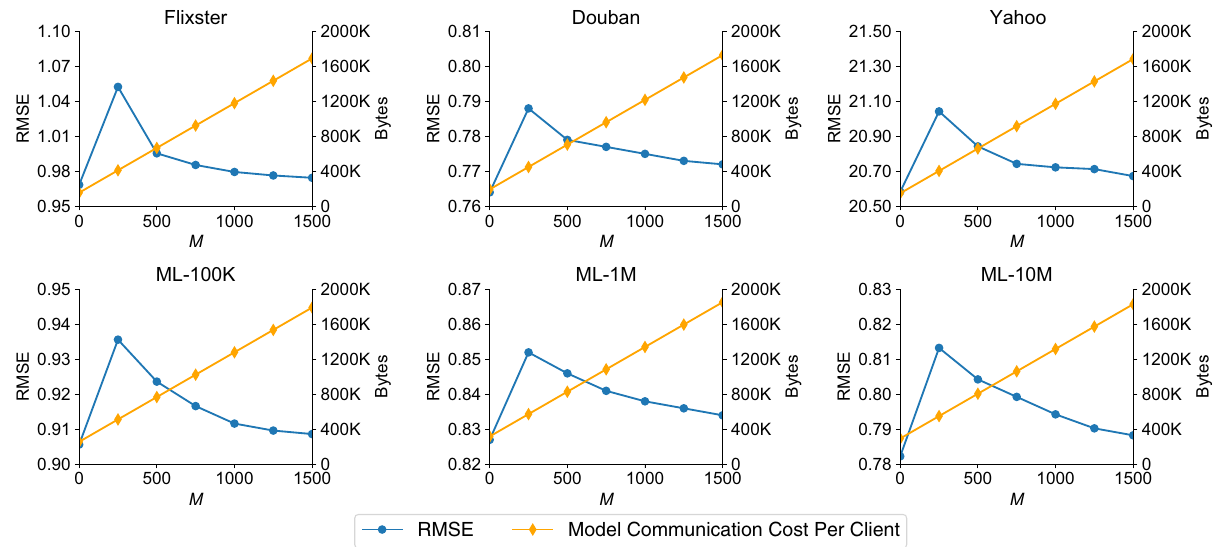
Fig. 5 The personalization RMSE (left y -axis) and communication cost (right y -axis) under different numbers of pseudo interacted items ( M ). The communication cost is the same for both downloading and uploading. The performance is optimal when there is no pseudo interacted item, but users' interaction histories are not protected. When the value of M is too small the performance loss is relatively large, while the performance improves and user privacy is better protected when M becomes larger. Since the communication cost is proportional to M , a moderated value of M (i.e., 1000) is chosen.